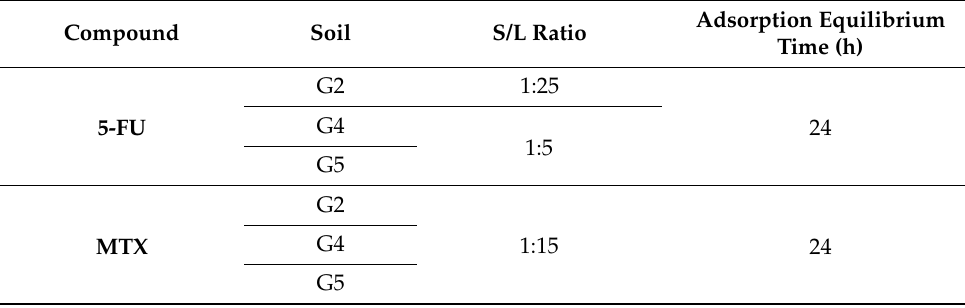
Table 5. Optimal S/L ratio and time of